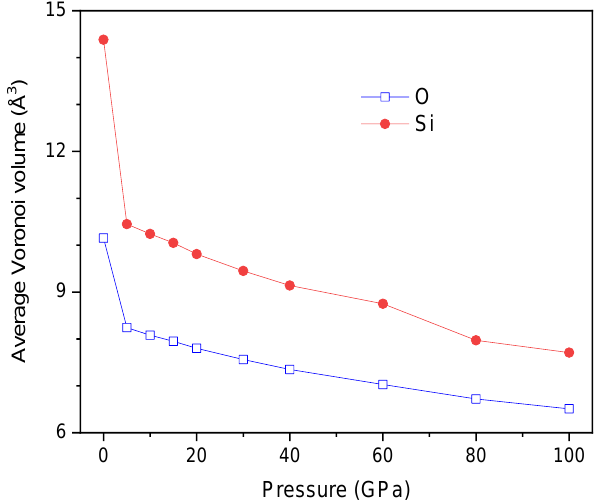
Figure 6. Pressure dependence of average Voronoi volume of Al-,